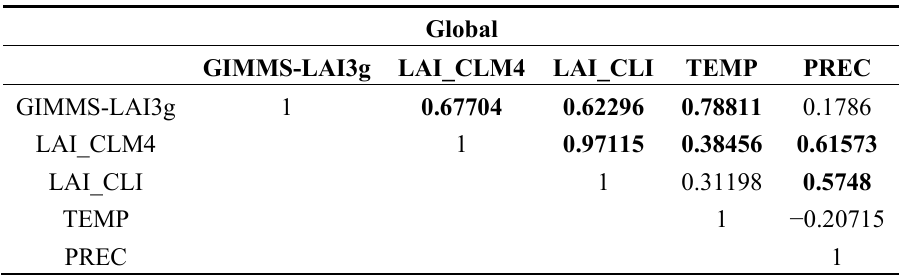
Table 2. Pearson correlations among the latitudinal trend of annual GIMMS-LAI3g, LAI_CLM4, LAI_CLI, TEMP and PREC from 1982 to 2009. Bold values mean correlations with significance (P <